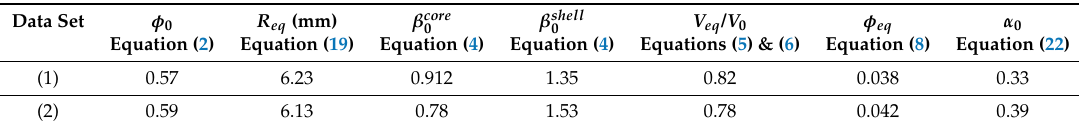
Table 4. Review of physical, geometrical and shrinkage parameters adopted in the moving-boundary model for the analysis of data set (1) and